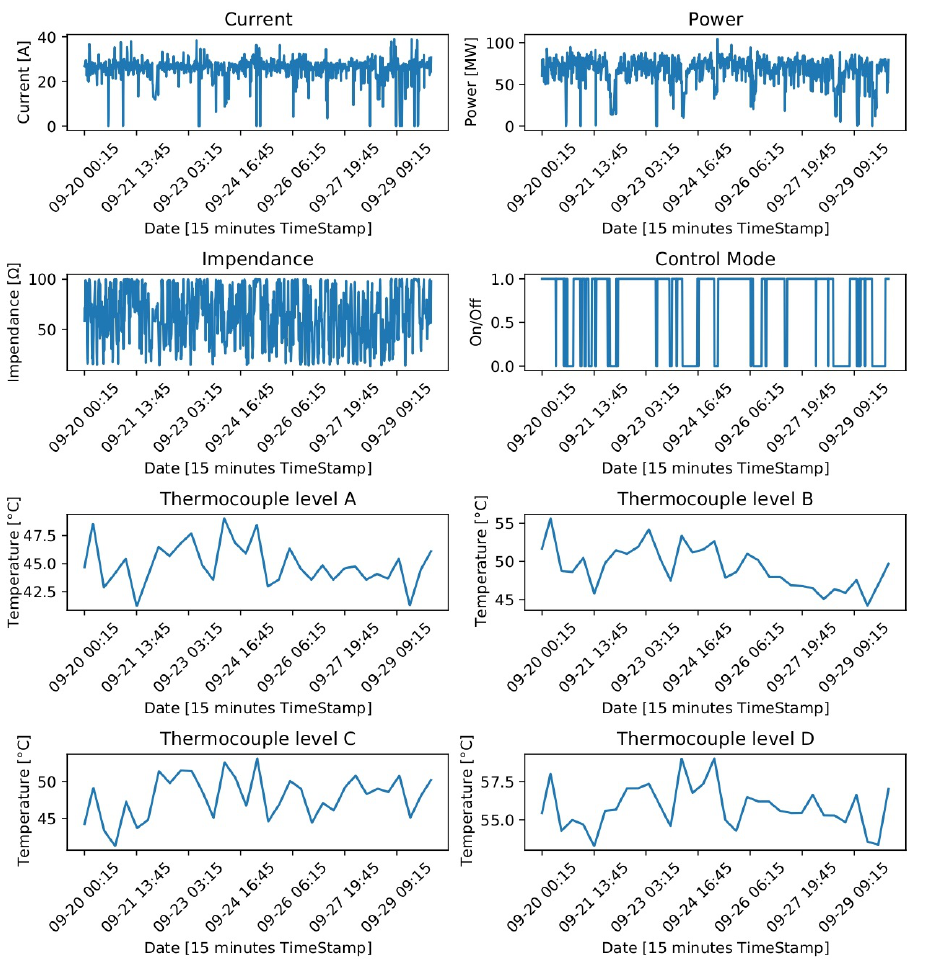
Figure 4. Time series plot of some input and output variables in the